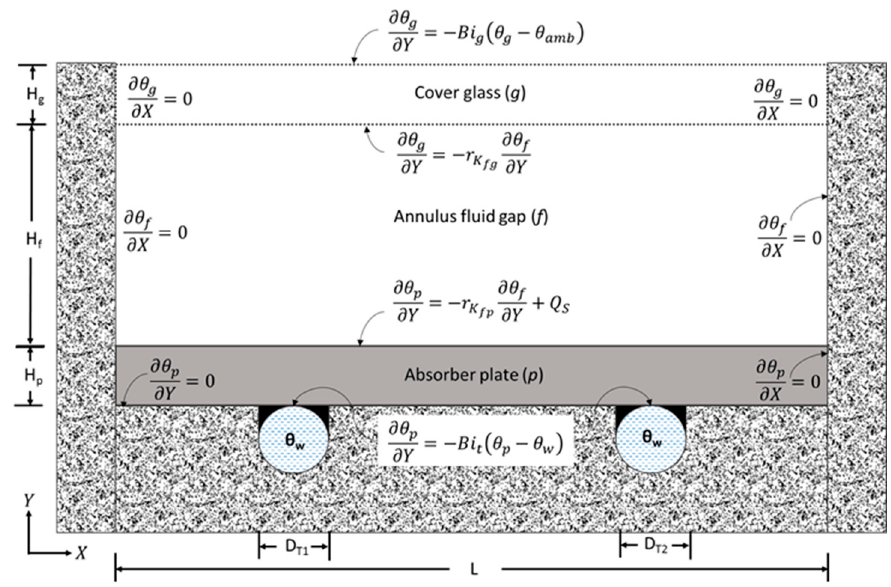
Figure 6. Schematic diagram of FPSC with boundary conditions.